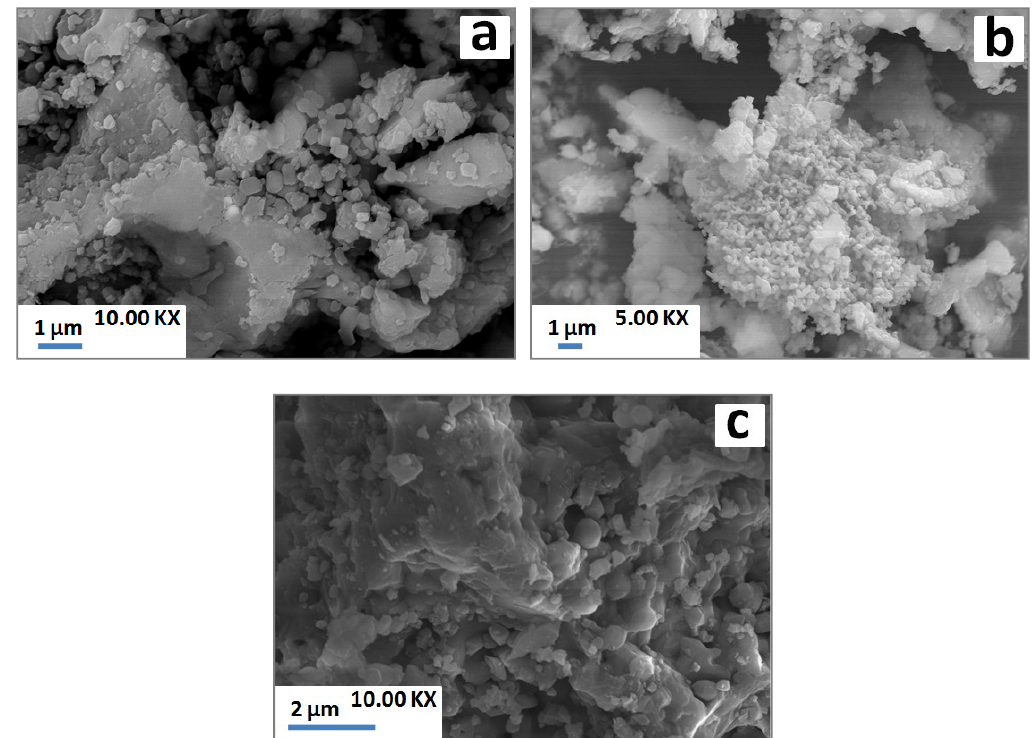
Figure 9. SEM micrographs of SA-PS-SC blends heated at 900 °C ( a and b ) and 1100 °C ( c ).